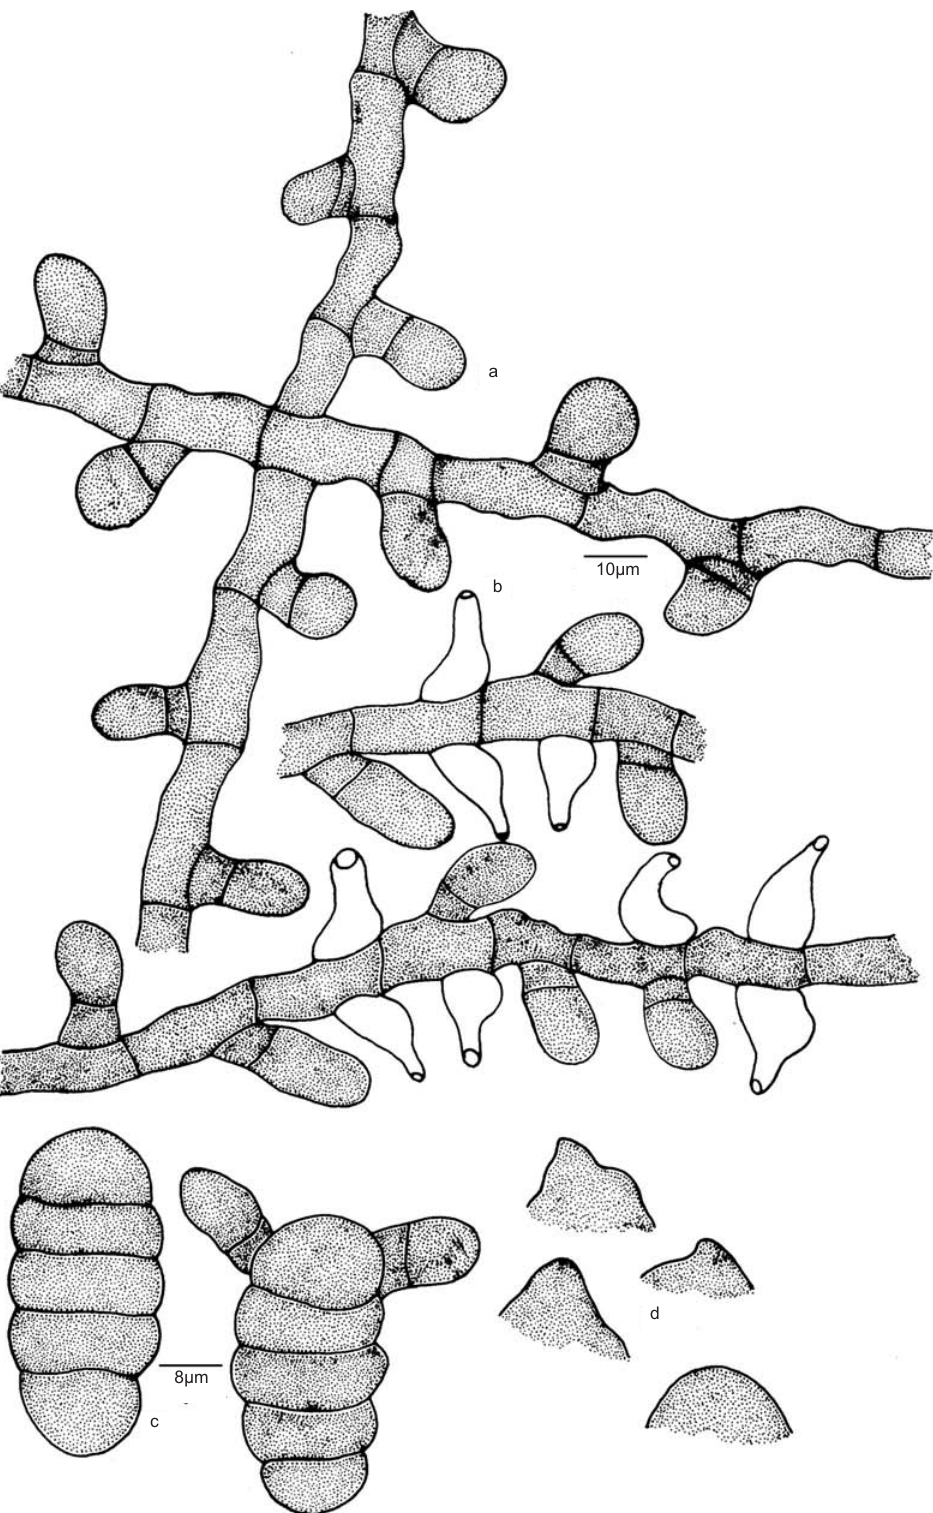
Figure 1. Asteridiella toddaliae sp. nov. a - Appressorium; b - Phialide; c - Ascospores; d - Perithecial wall cells